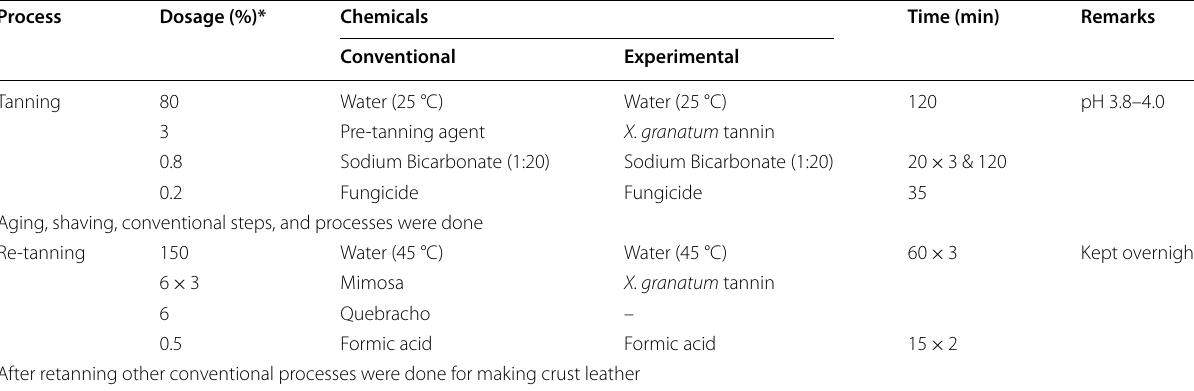
Table 1 Tanning, and retanning process of goat skin